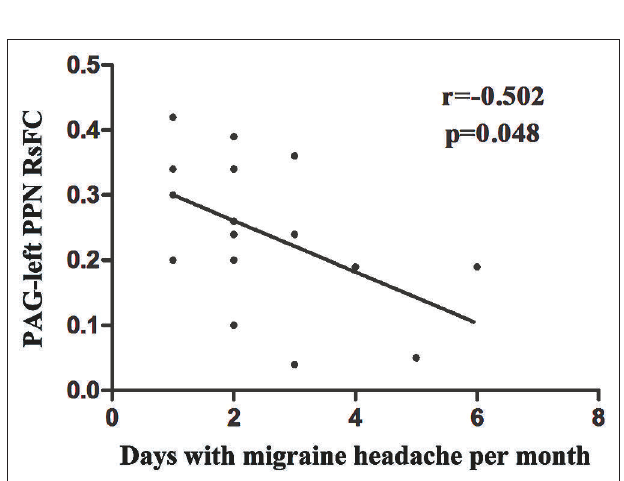
FIGURE 4 | The relationship between PAG-left PPN RsFC and migraine